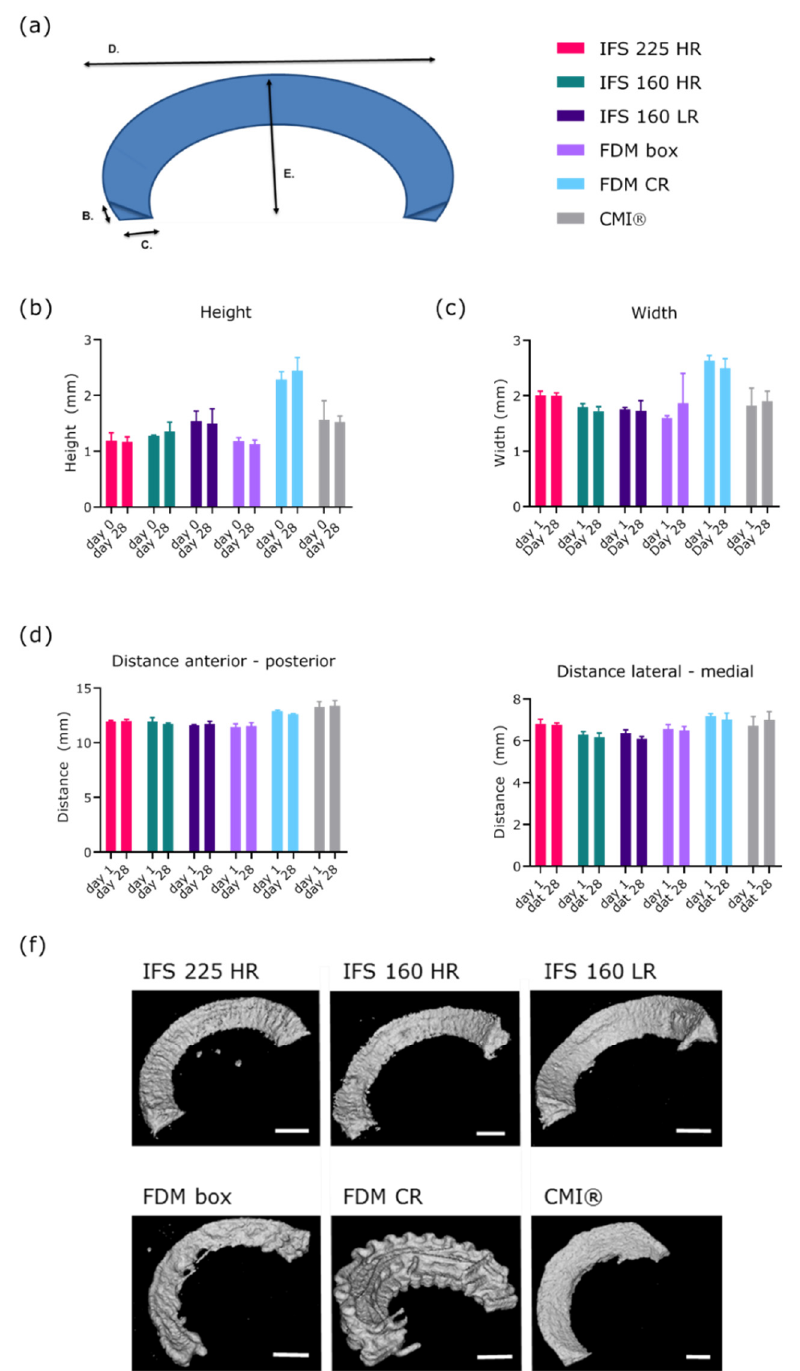
Figure 4. ( a ) Schematic overview of measured dimensions ( b ) height of the scaffold, ( c ) width of the scaffold, ( d ) anterior-posterior distance, ( e ) lateral-medial distance, ( f ) representative µ CT images per group after 28 d of culture. n = 3 donors, 1-2 technical replicates per donor. Abbreviations; 160: 160 µ m, 225: 225 µ m, CMI ® : Collagen Meniscus Implant ® , IFS: inter fibre spacing, HR: high ratio of radial fibres, LR: low ratio of radial fibres, FDM: fused deposition modelling, CR: circumferential and radial fibres, Box: box-structure. Scale bar is 2